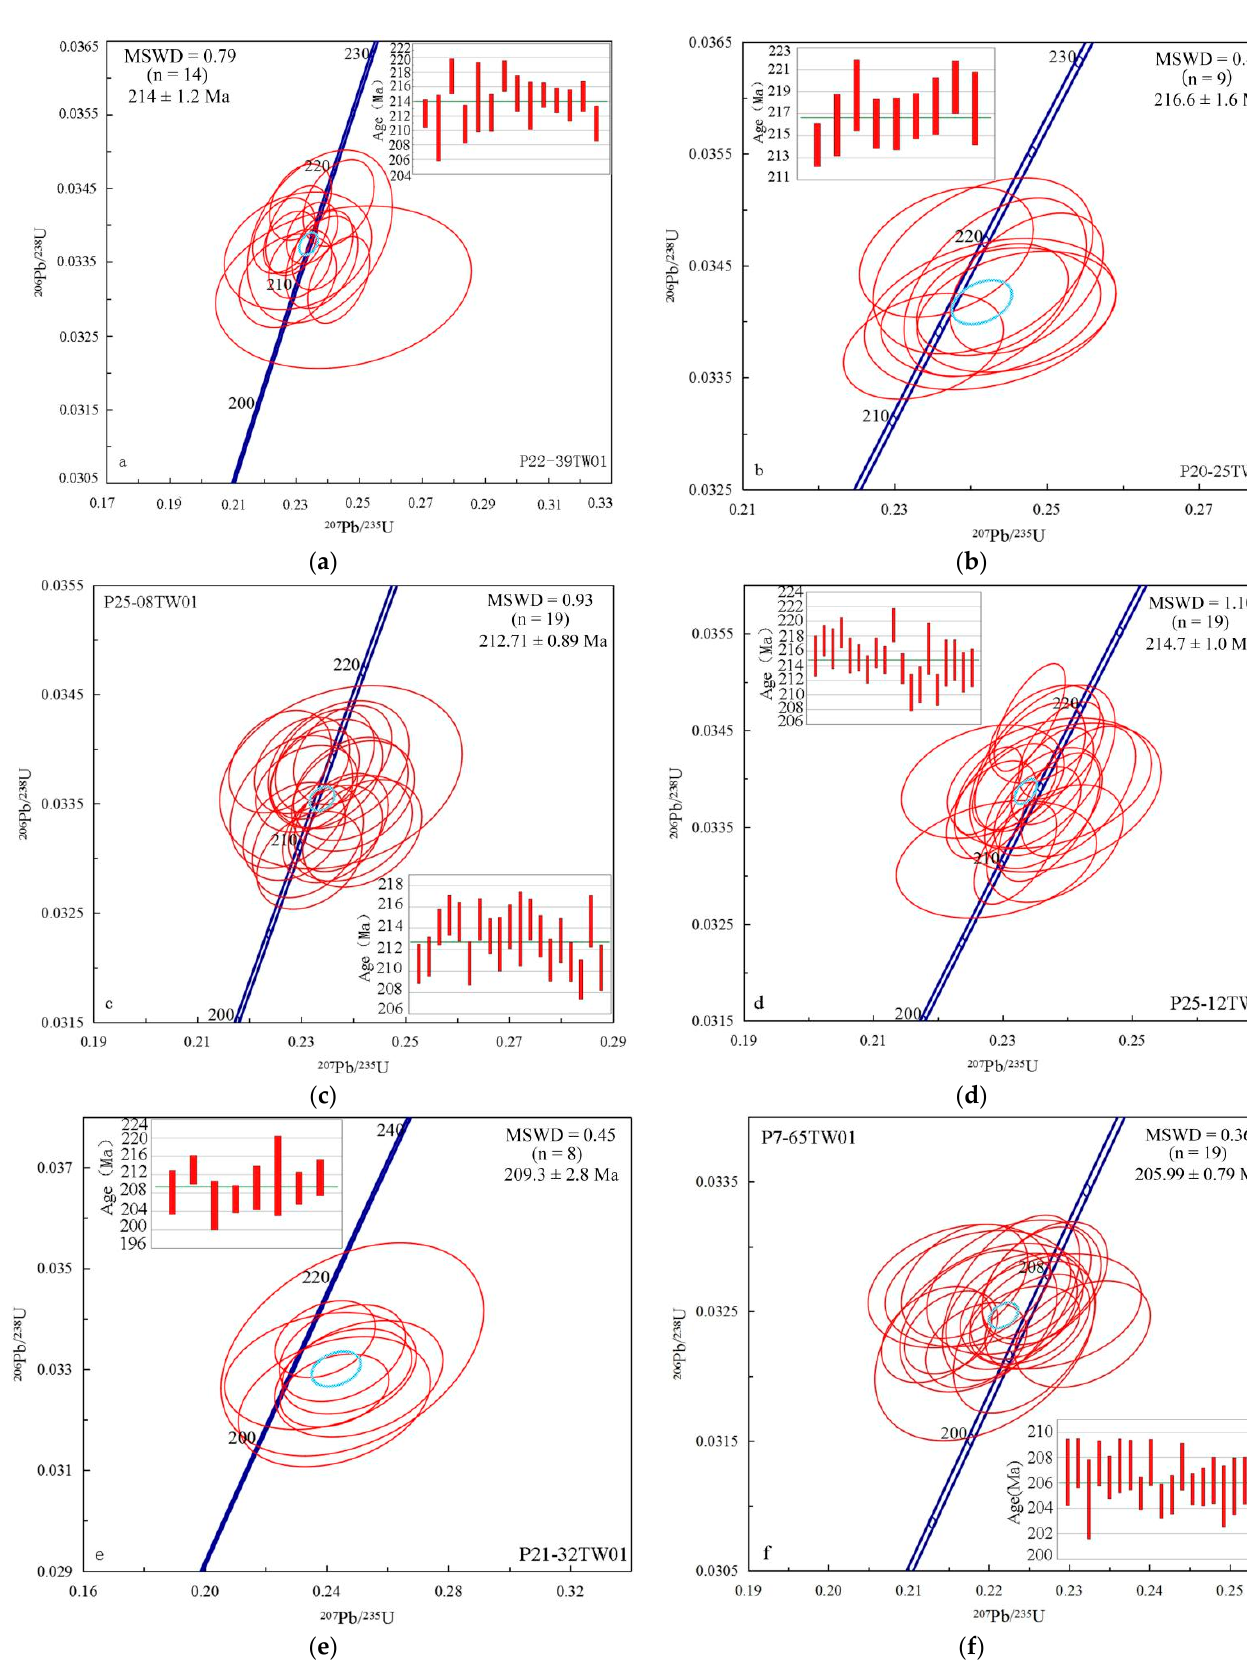
Figure 6. Concordia diagrams for granite samples from the Dahongliutan pluton. ( a ) P22-39TW01, ( b ) P20-25TW01, ( c ) P25-08TW01, ( d ) P25-12TW, ( e ) P21-32TW01, and ( f ) P7-65TW01.